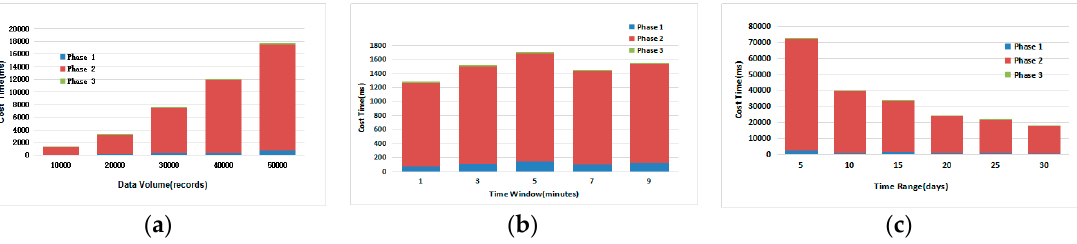
Figure 11. Cost Time for Different Phases in Query Process: ( a ) Varying Data Volume; ( b ) Varying Time Window; ( c ) Varying Time Range.